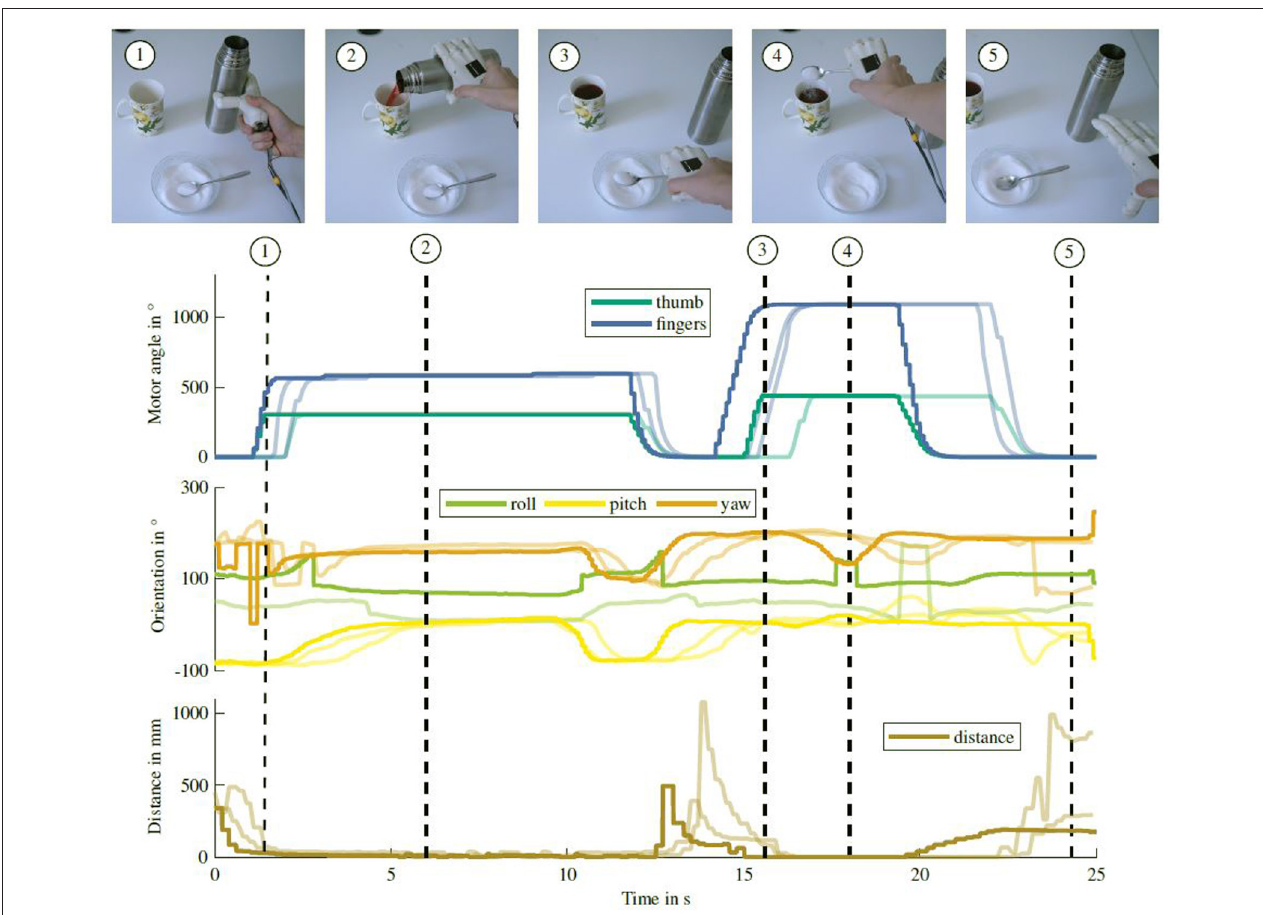
FIGURE 10 | Sensor readings while pouring tea into a cup and adding sugar with a spoon. Graph notation is similar to the lemonade preparation task shown in Figure 9